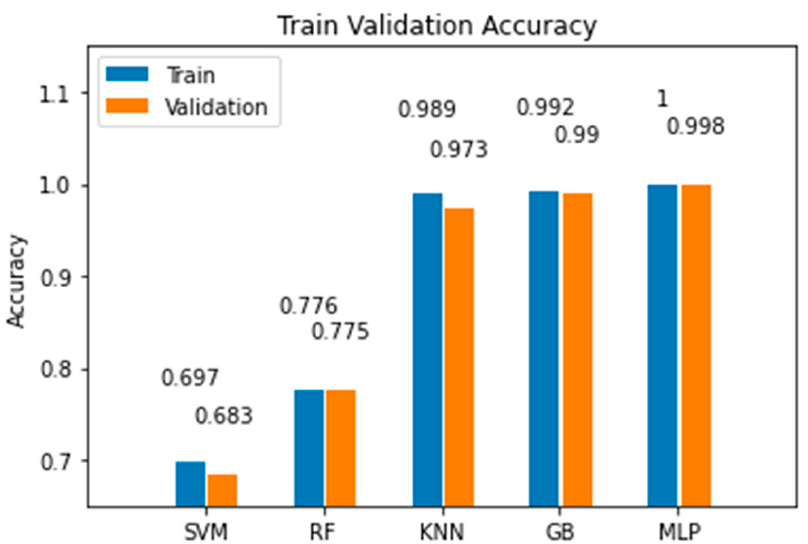
Figure 13. Comparison of the accuracy achieved for the training and validation data by the MLP model against other machine learning models.